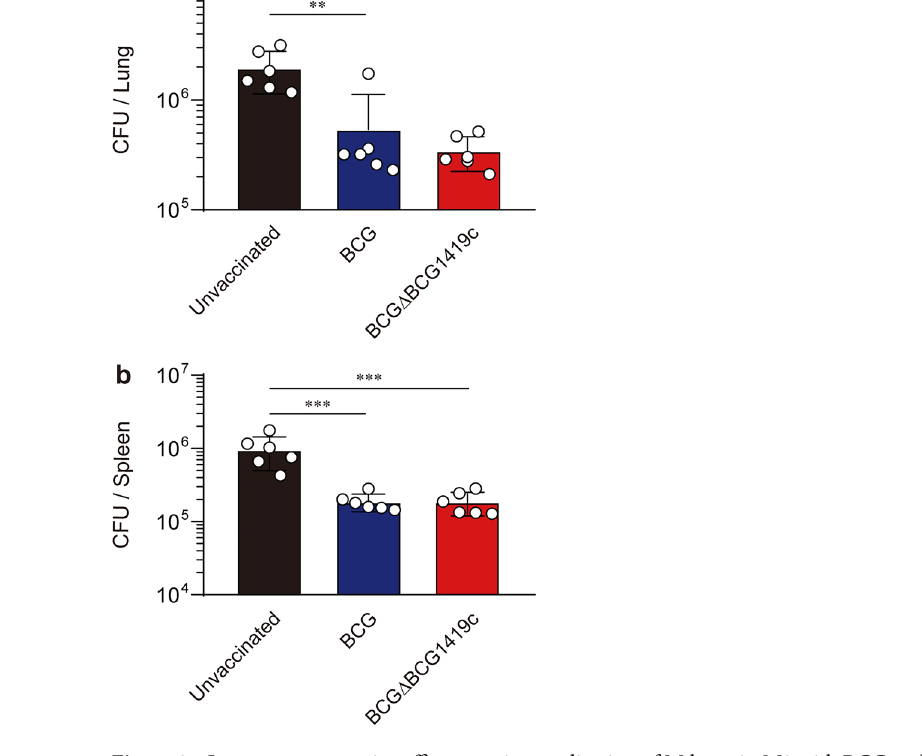
reduce the levels of structural changes related to lung inflammation in our murine model as it did after low-dose (100 CFUs of Mtb H37Rv) infection of C57BL/6 mice 19 and very-low-dose (10–20 CFUs of Mtb H37Rv) infec- tion of guinea pigs 23 . Thus, mice from the unvaccinated and vaccinated groups were euthanised at 10 weeks post- infection with Mtb strain M2, and histopathological analysis of the lungs was performed (Fig. 4a). Notably, mice vaccinated with BCGΔBCG1419c exhibited significantly reduced lung tissue damage compared to unvaccinated mice, as evidenced by the peribronchiolitis ( p = 0.0489), alveolitis ( p = 0.0107), and total lung scores ( p = 0.0013). Furthermore, BCG-vaccinated mice did not have a significantly ameliorated total lung score compared to that of